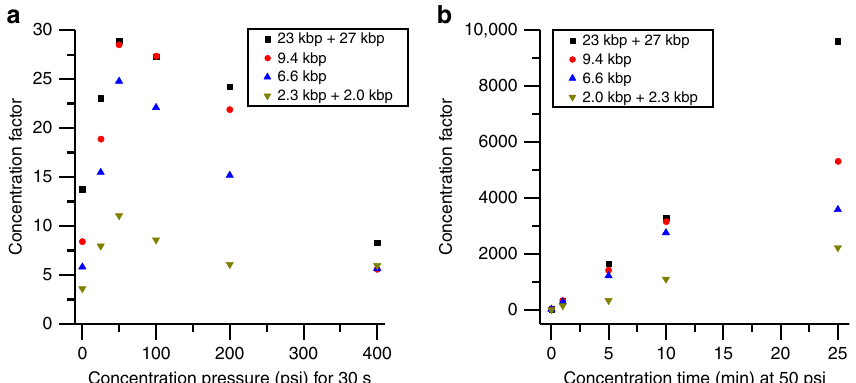
Fig. 4 Effects of pressure and time on the concentration enhancement. a High concentration running buffer (25 mM Tris-HCl buffer) is pumped through the capillary (5 μ m nominal inner diameter, 150 μ m outer diameter, 120 cm total length) into the reservoir ( λ DNA Hin dIII digest in DI water) for 30 s at varying pressures. The highest concentration factor occurs at 50 psi pressure. b Using the optimal 50 psi concentration pressure, concentration time is varied from 30 s to 25 min. The concentration factor increases with time for all DNA species